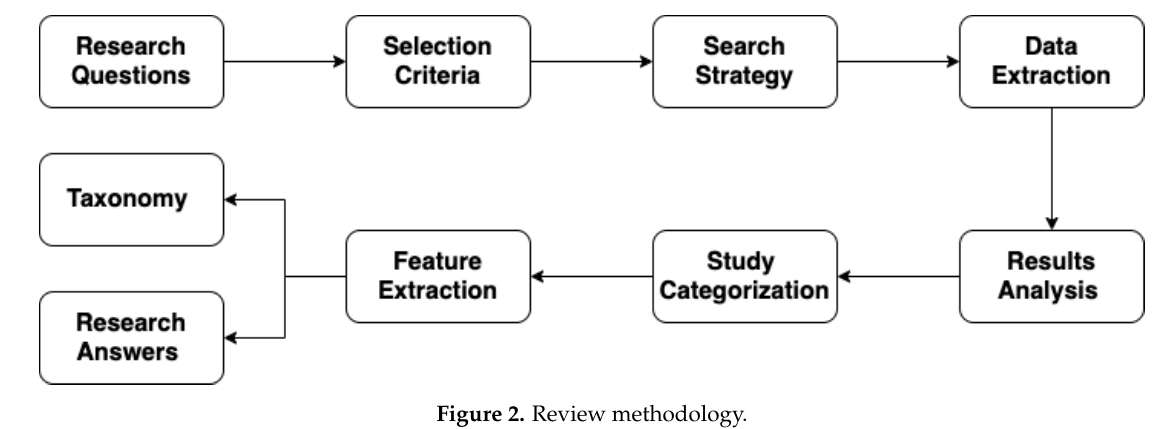
Figure 2. Review